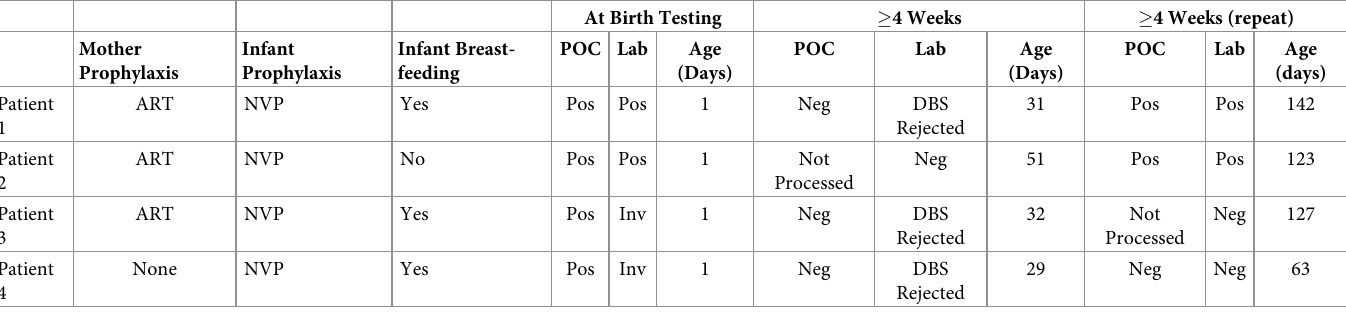
Table 3. Patients with discordant test results between birth and after four